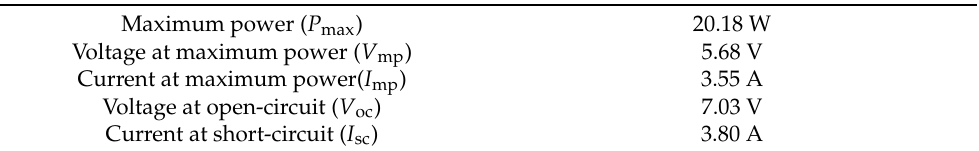
Table 1. PV panel rating at standard temperature condition ( STC ): Irradiance ( E ) = 1000 W/m 2 and Temperature ( T ) = 25°.